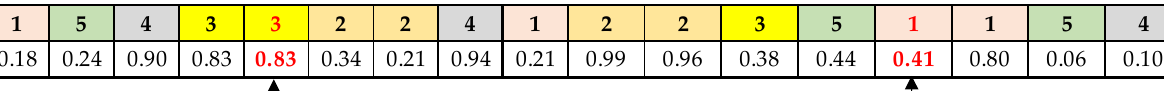
Figure 7. Crossover operator based on single crossing point. The mutation operator is applied after creating the offspring alphas, generating a random number for each offspring. If this random number is less than the probability of mutation MR, the mutation operation is performed using the swapping mutation method (exchange mutation), where two randomly chosen genes are exchanged through a SWAP movement [36,37] (see Figure 8).